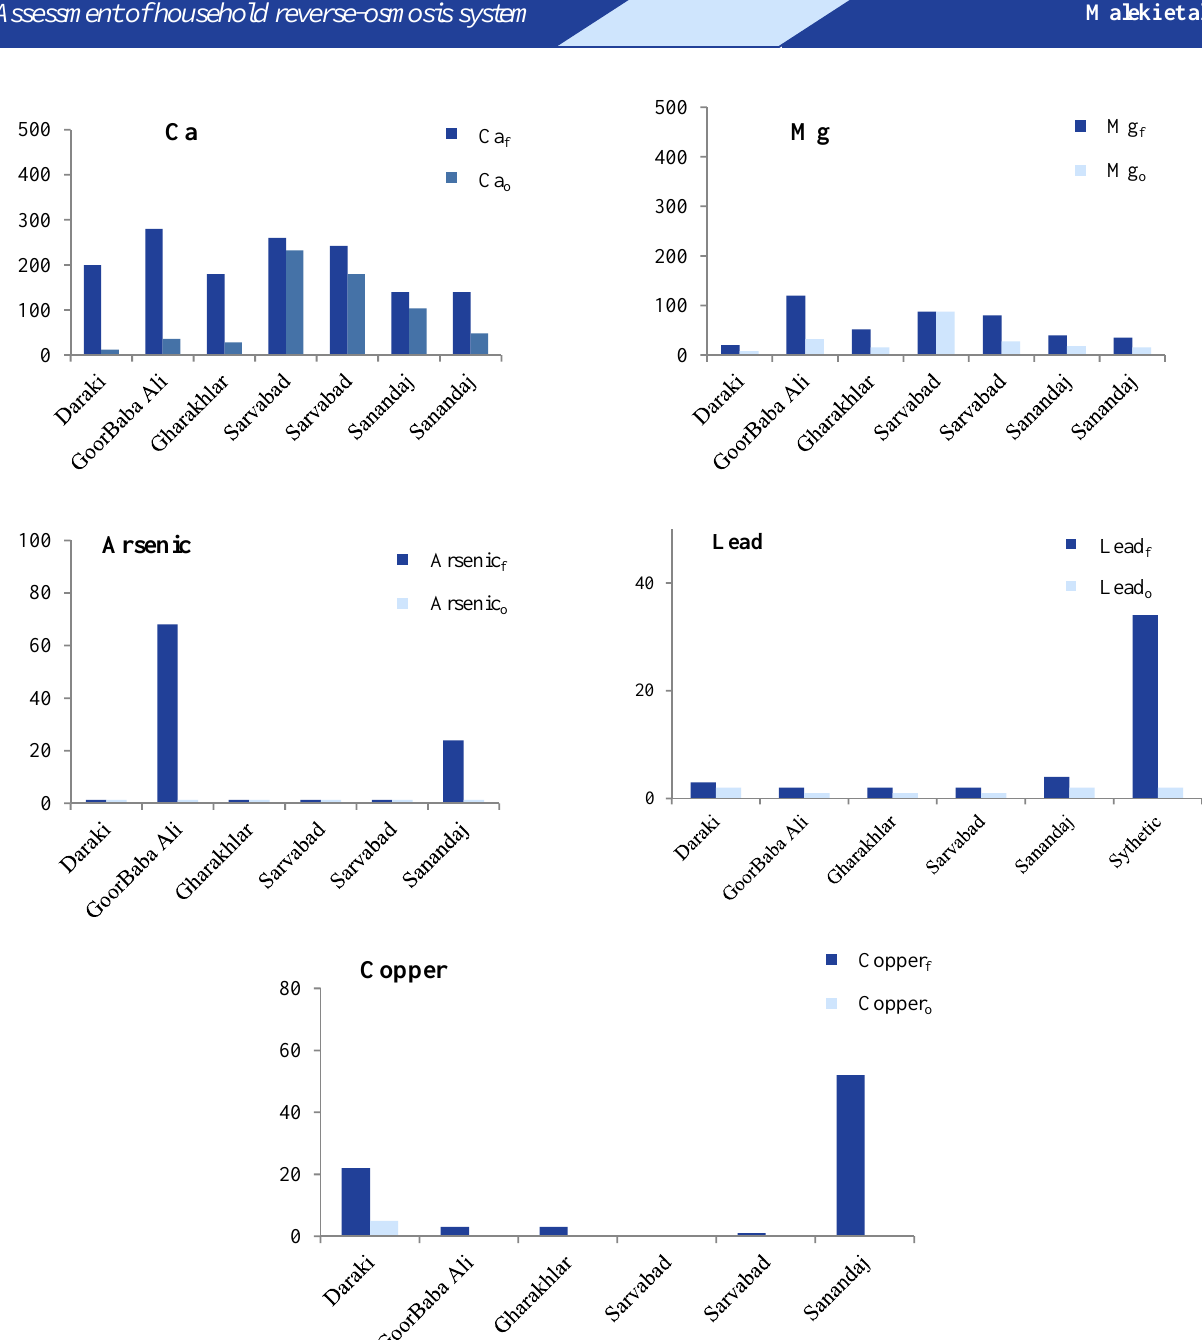
Figure 3. Physico-chemical compression for whole investigated species in feed and output water quality